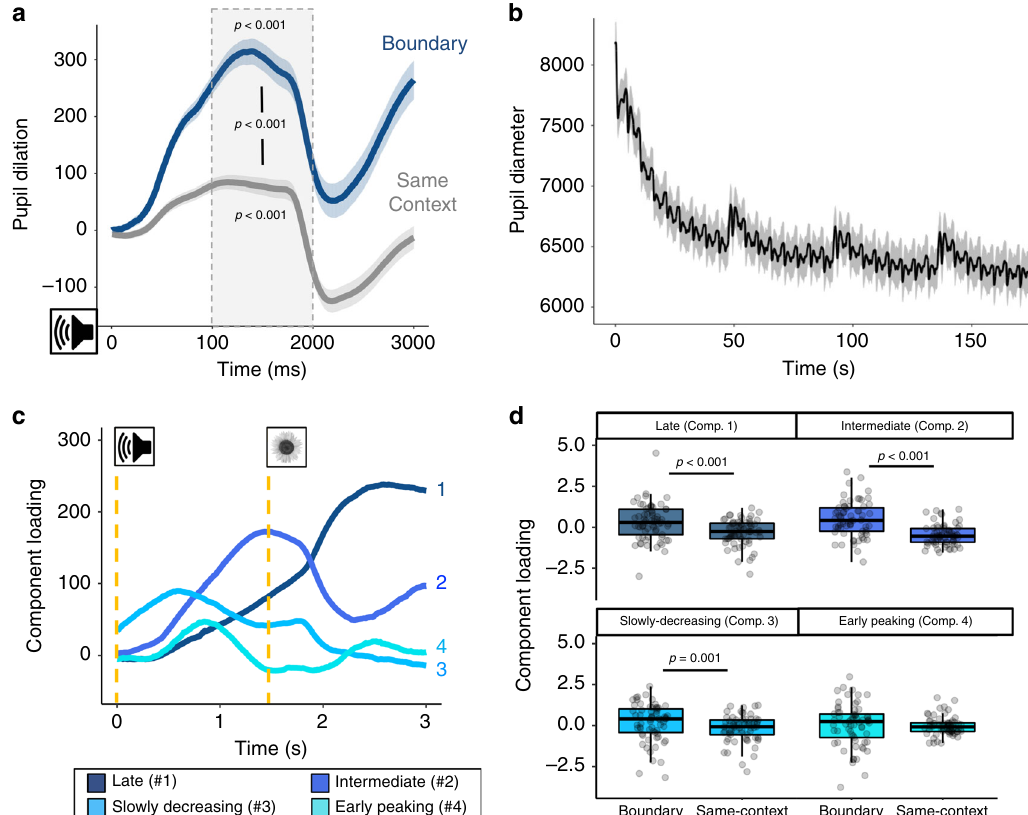
Fig. 5 Event boundaries modulate temporal characteristics of pupil dilation. a The effects of boundary (tone switches; blue) versus same-context tones (repeated; gray) on pupil dilation. Shaded areas represent s.e.m. b Average fl uctuations in pupil diameter across the encoding sequence, averaged across all blocks, experiments, and participants. The gray shaded area represents s.e.m. c Temporal features of tone-evoked pupil dilation identi fi ed by a temporal principal component analysis (PCA). The PCA revealed four signi fi cant features of pupil dilation that had distinct shapes over time. Component loadings re fl ect “ raw ” values from the rotated solution, so are on the same scale as the original inputs. Gold dashed lines signify the onsets of the tones and their subsequent images. d The boundary tones (blue colors) versus same-context tones (gray) differentially modulated loading scores for the fi rst three pupil components but not the fourth component. Colored boxplots represent 25th – 75th percentiles of the data, the center line the median, and the error bars the s.e.m. Overlaid dots represent individual participants (Experiment 2: n = 35; Experiment 3: n = 30). Two-tailed paired pairwise t -tests were performed to test for signi fi cant differences between factor-loading values for boundary trials compared to same-context trials. No adjustments were made for multiple comparisons. Source data are provided as a Source Data fi